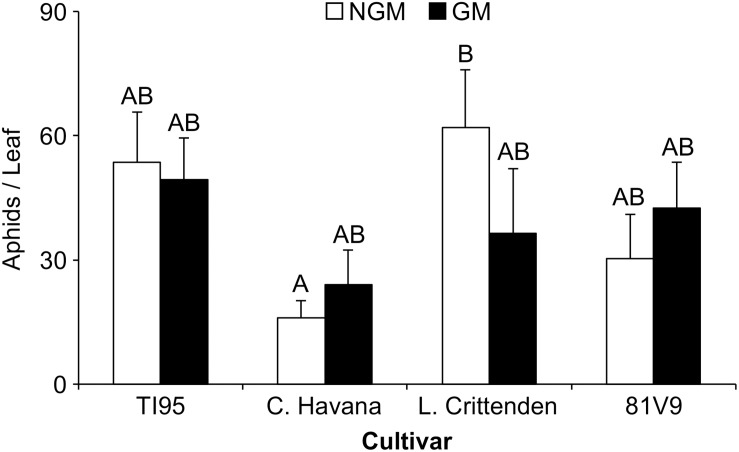
PFA has no effect on short-term tobacco aphid survival and fecundity. Mean aphid numbers ± S.E. on GM and NGM tobacco cultivars. Aphid numbers were averaged between 3 leaves per plant for 3 separate trials under field conditions. Bars with the same letter are not statistically different (2-way ANOVA, Tukey’s pairwise comparison, P < 0.05). Error bars represent the standard error of the mean.